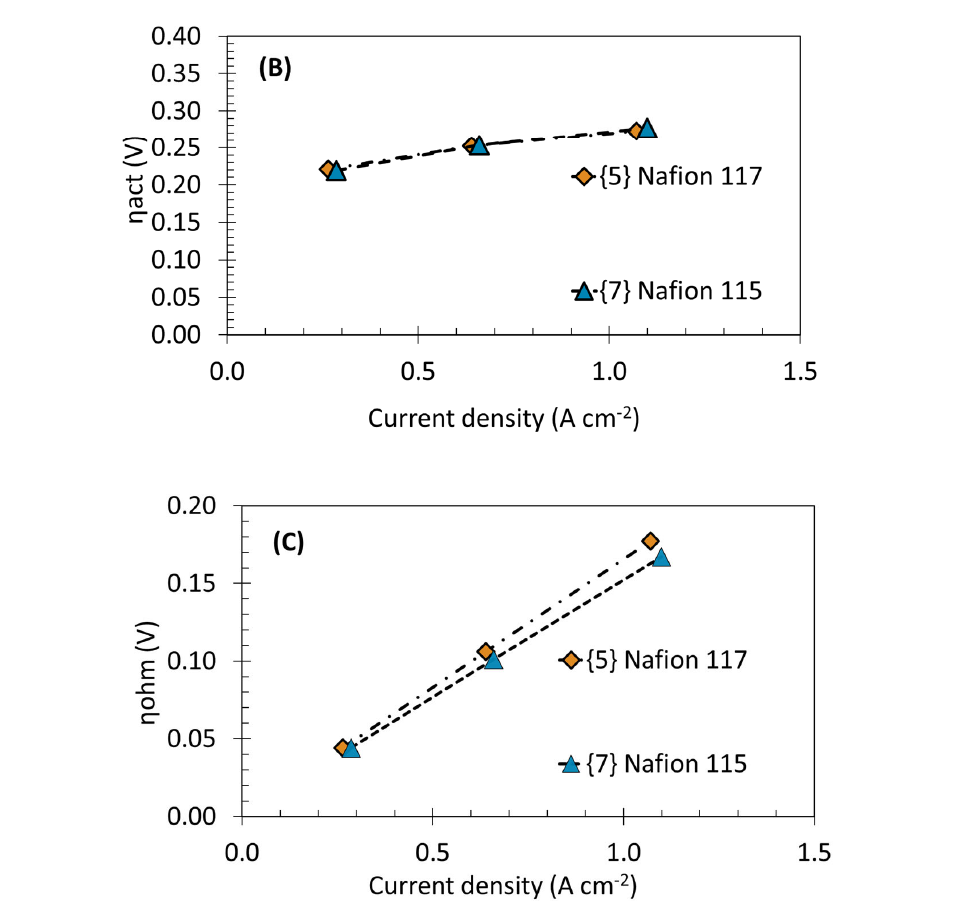
Figure 4. Data of CCMs with different membrane thicknesses operating at 80 °C. ( A ) ‐ I ‐ V curves, ( B ) ‐ activation overpotentials, ( C ) ‐ ohmic overpotentials. ( B )-activation overpotentials, ( C )-ohmic